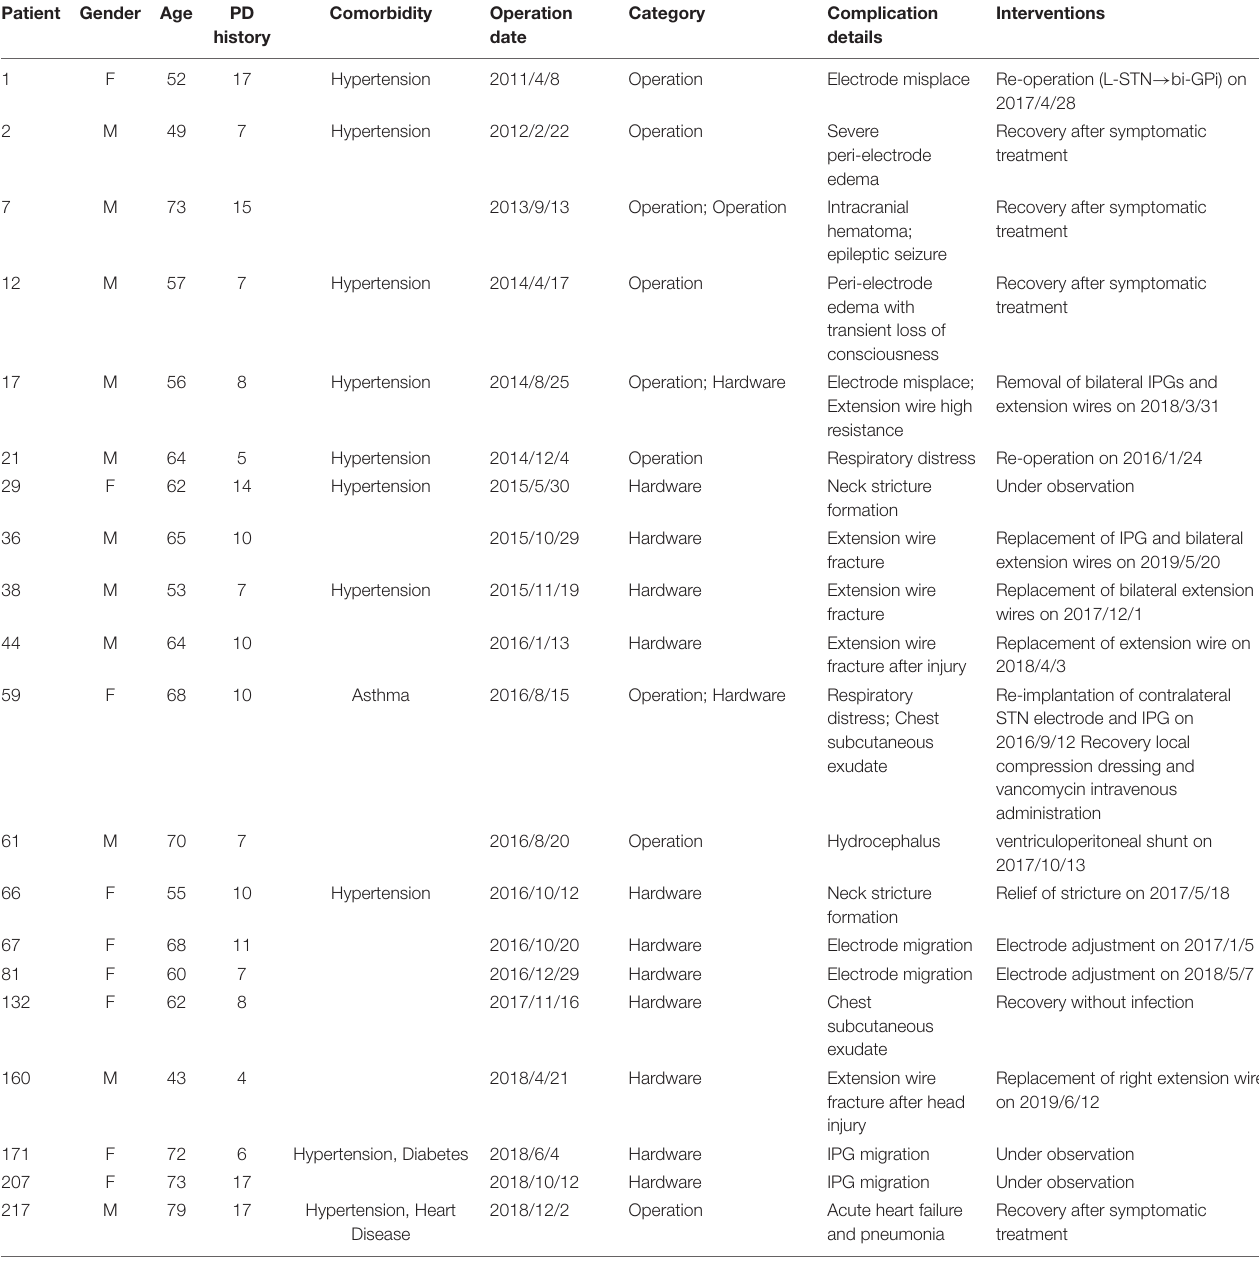
TABLE 2 | Causes and interventions of complications. Patient Gender